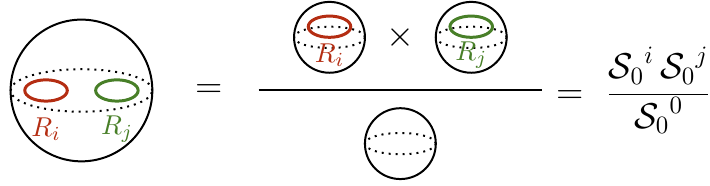
(cid:2) S 3 (cid:3) ; R i , R j by applying (2.18) and